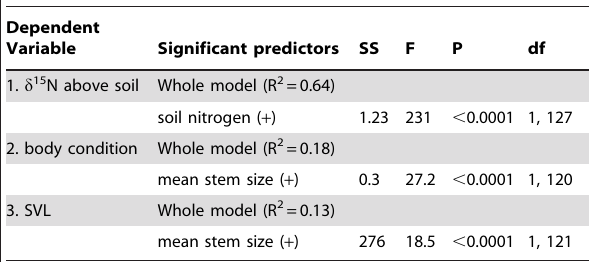
Table 2. Significant predictors of gecko trophic position, body size (SVL), and body condition from a multiple stepwise